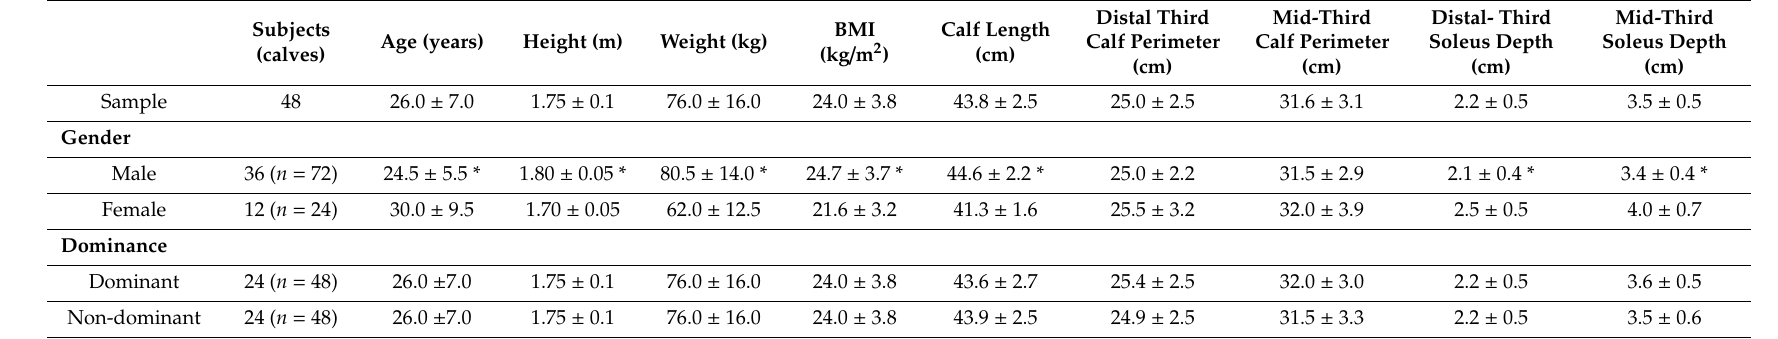
Table 1. Anthropometric features and soleus muscle depth of the total sample and by